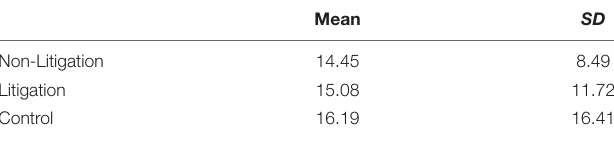
TABLE 2 | Descriptive information for symptom endorsement by